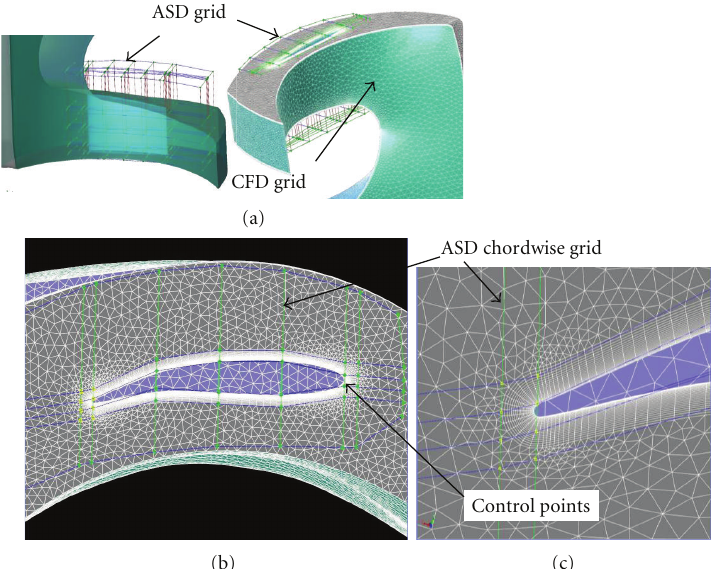
Figure 11: Blade design parameters are defined with ASD grid (a) a 3D view; (b) a chordwise view with a deformed blade; (c) a close-up view at the trailing-edge region of the deformed blade.